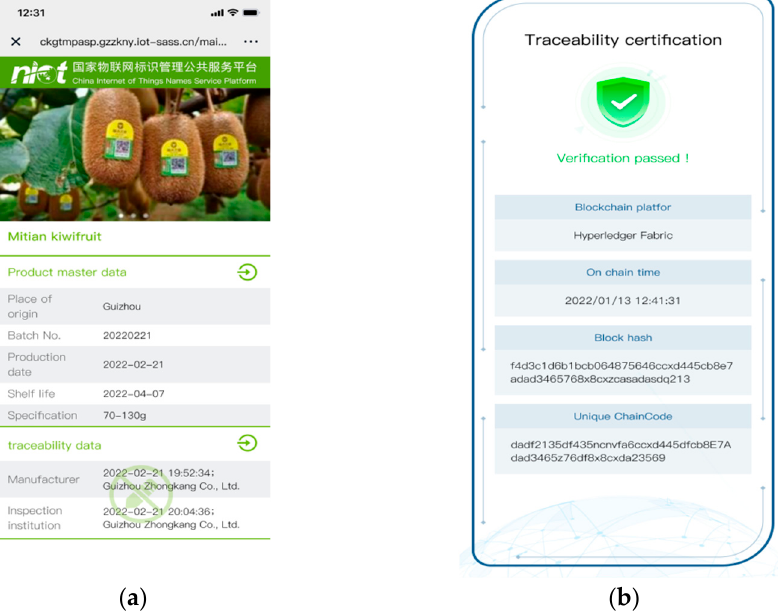
Figure 12. The traceability information shown on the mobile phone. ( a ) Product traceability information; ( b ) Data integrity validation.